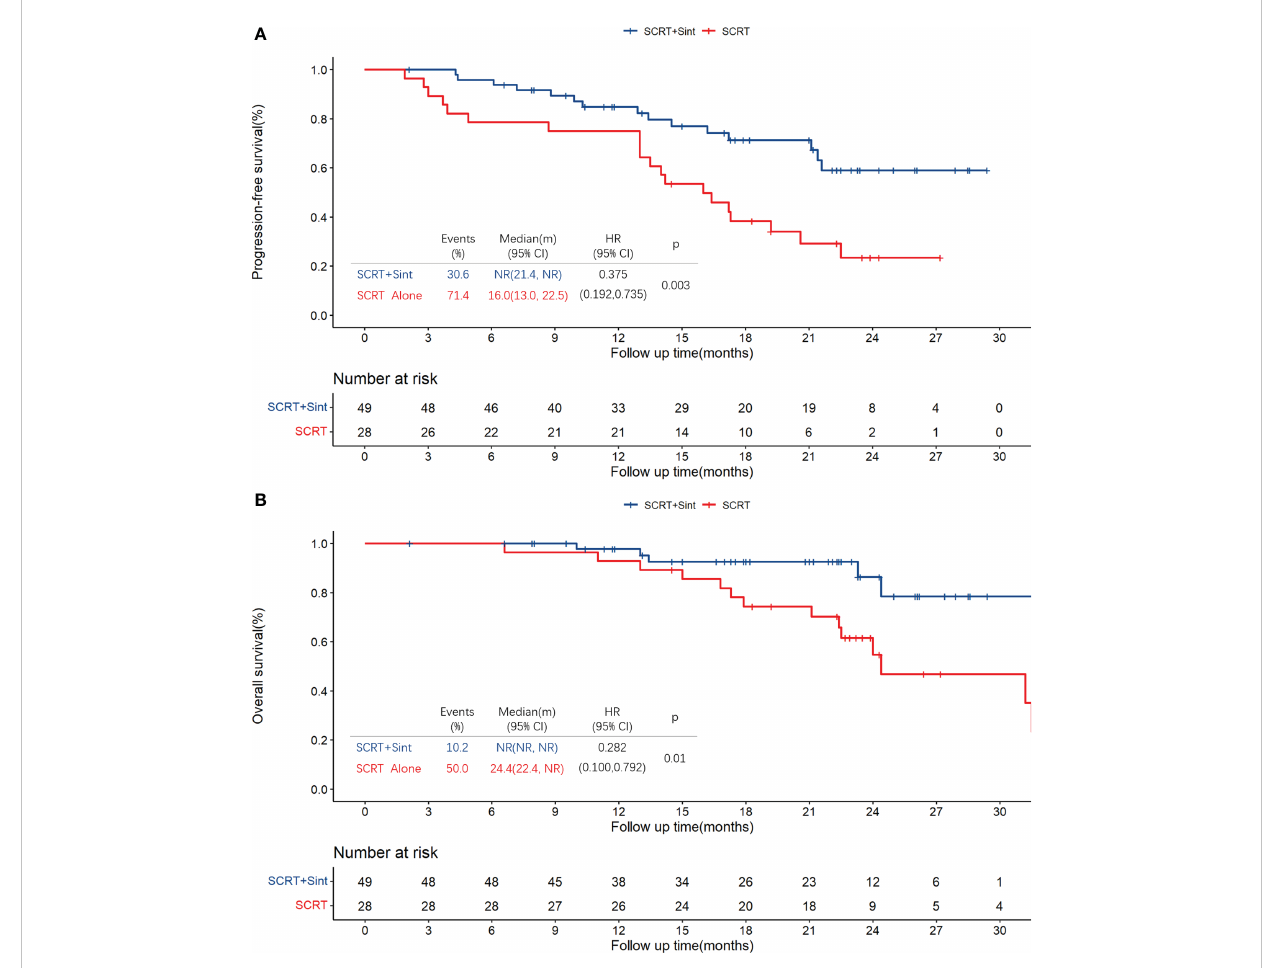
FIGURE 2 Kaplan-Meier plots for PFS (A) and OS (B) in all patients. PFS, progression-free survival; OS, overall survival; SCRT, sequential chemoradiotherapy; Sint,